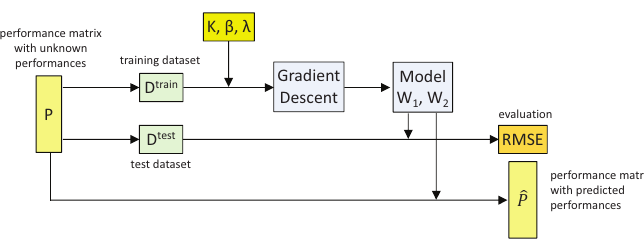
Figure 1. Scheme with the main steps followed by the prediction